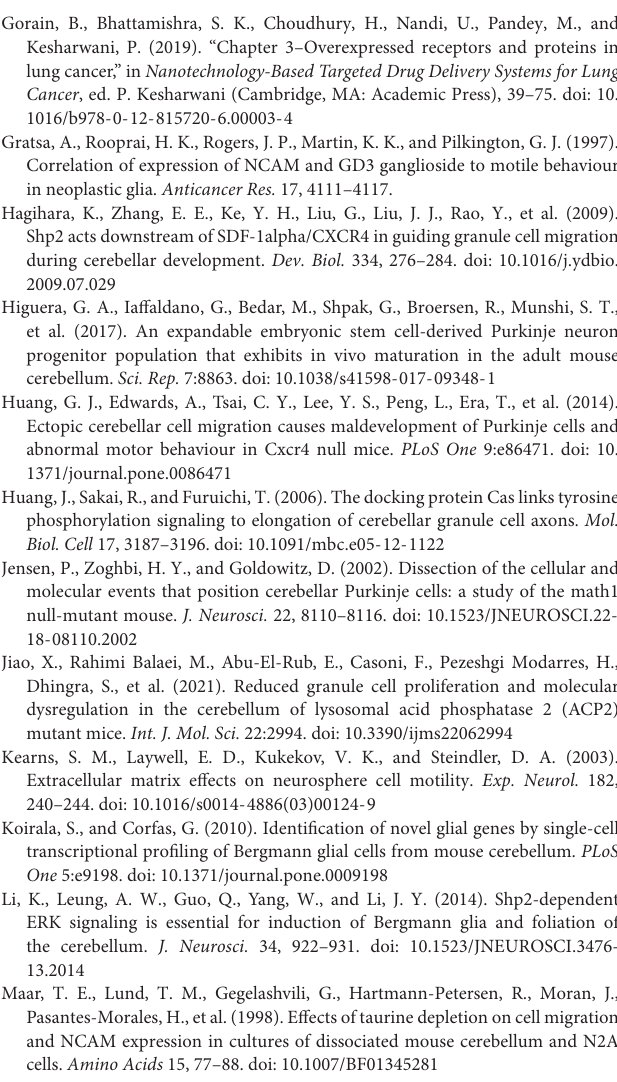
Supplementary Figure 1 | Expression of NCAM1 at P2, P5, and P7 in both wt and nax cerebellum by using Western blot; NCAM expression in wt and nax cerebellum is downregulated at P5 and P7. Supplementary Figure 2 | (A–D) FACS analysis of NEPH3 positive (Purkinje cells) and GLAST1 positive (Bergmann glia cells) from nax and wt mice cerebellum at the age of P2 (A,B) and P7 (C,D) . (E) We used cells incubated with secondary antibodies and DAPI only to set up the cut off levels for accurate sorting of the cells. The very low percentage of the cells were double positive (DP) which were excluded from mRNA extraction and the rest are double negative cells which are most of the cerebellar cells in both strains. Supplementary Figure 3 | The RNAseq data sets from the cerebellum at P5/P7 shows significant difference in expression of Itg α 3 and Itg α 5 between nax and wt littermate (** p < 0.01, *** p <